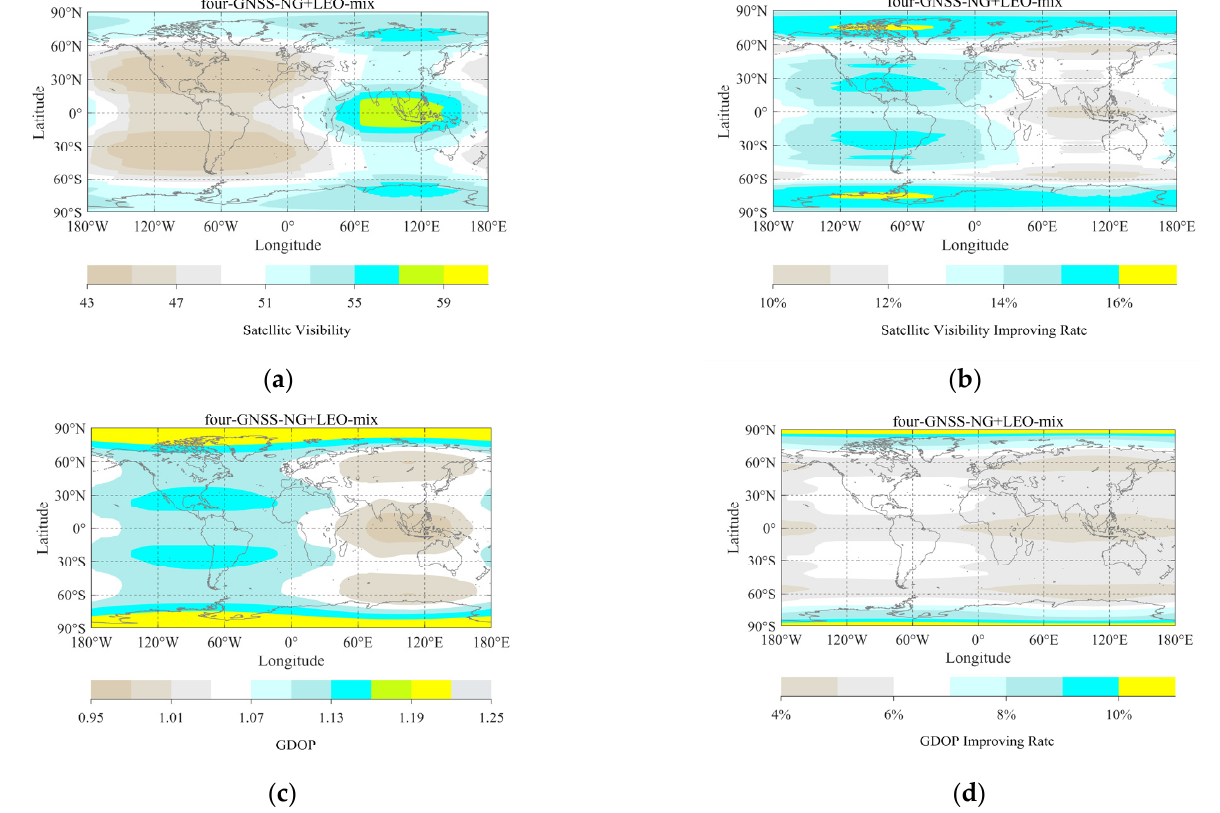
Figure 10. Satellite visibility and GDOP of the four-GNSS-NG+LEO-mix satellites and their improvement rate: ( a ) visible satellites of four-GNSS-NG+LEO-mixed; ( b ) visible satellites improvement rate of the four-GNSS-NG+LEO-mix compared to that of the four-GNSS-NG; ( c ) GDOP of the four-GNSS-NG+LEO-mix; ( d ) GDOP improvement rate of the our-GNSS- NG+LEO-mix compared to that of the four-GNSS-NG.